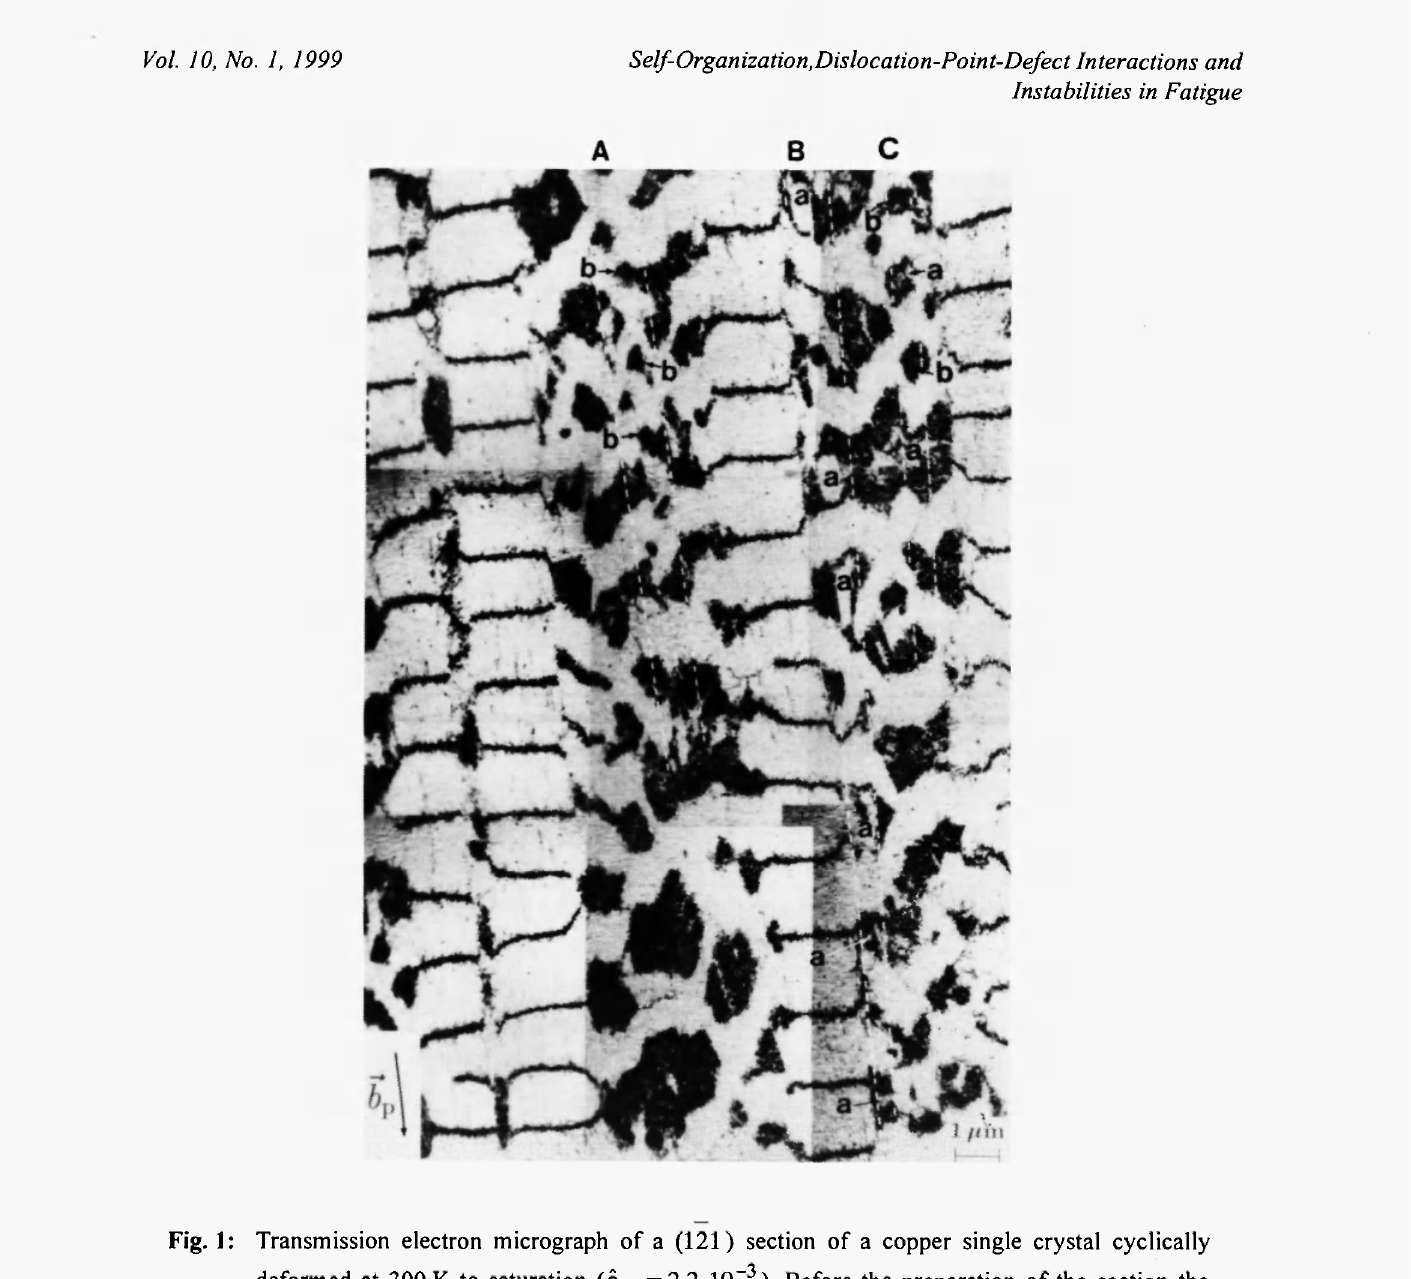
Fig. 1: Transmission electron micrograph of a (121) section of a copper single crystal cyclically A. —'X deformed at 300 Κ to saturation (ε ρ) = 2 . 2 10 ). Before the preparation of the section the crystal was irradiated with fast neutrons in order to fix the dislocation pattern. b p =(101) denotes the Burgers vector of the primary glide system; the diffraction vector was (202). The regions with the quasi-regular ladder structure are persistent slip bands; the faint lines parallel to b p between the rungs are screw dislocations. A, B, C denote incipient persistent slip bands developing inside the matrix. The letter a denotes regions of low dislocation densities that have developed inside the matrix at approximately constant separations. Examples of regions of higher-than-average dislocation density developing with approximately constant separations are indicated by the letter b. (Courtesy of U. Holzwarth